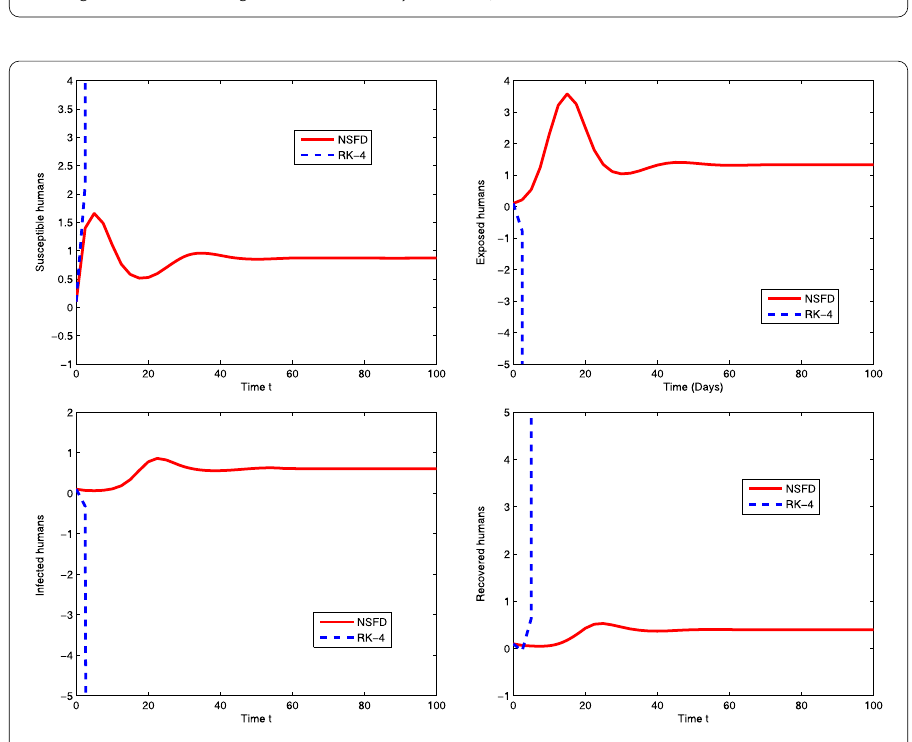
Figure 9 Comparison of solutions obtained by NSFD and RK4 numerical schemes for F 1 with an initial condition ( S (0), E (0), I (0), R (0)) = (0.1,0.1,0.1,0.1) and step size h = 2.5 with R 0 = 7.0735 > 1. The comparison shows that the RK4 scheme fails to converge, whereas the NSFD scheme improves the result obtained by RK4 and it is seen to be convergent dynamically to the correct endemic equilibrium F